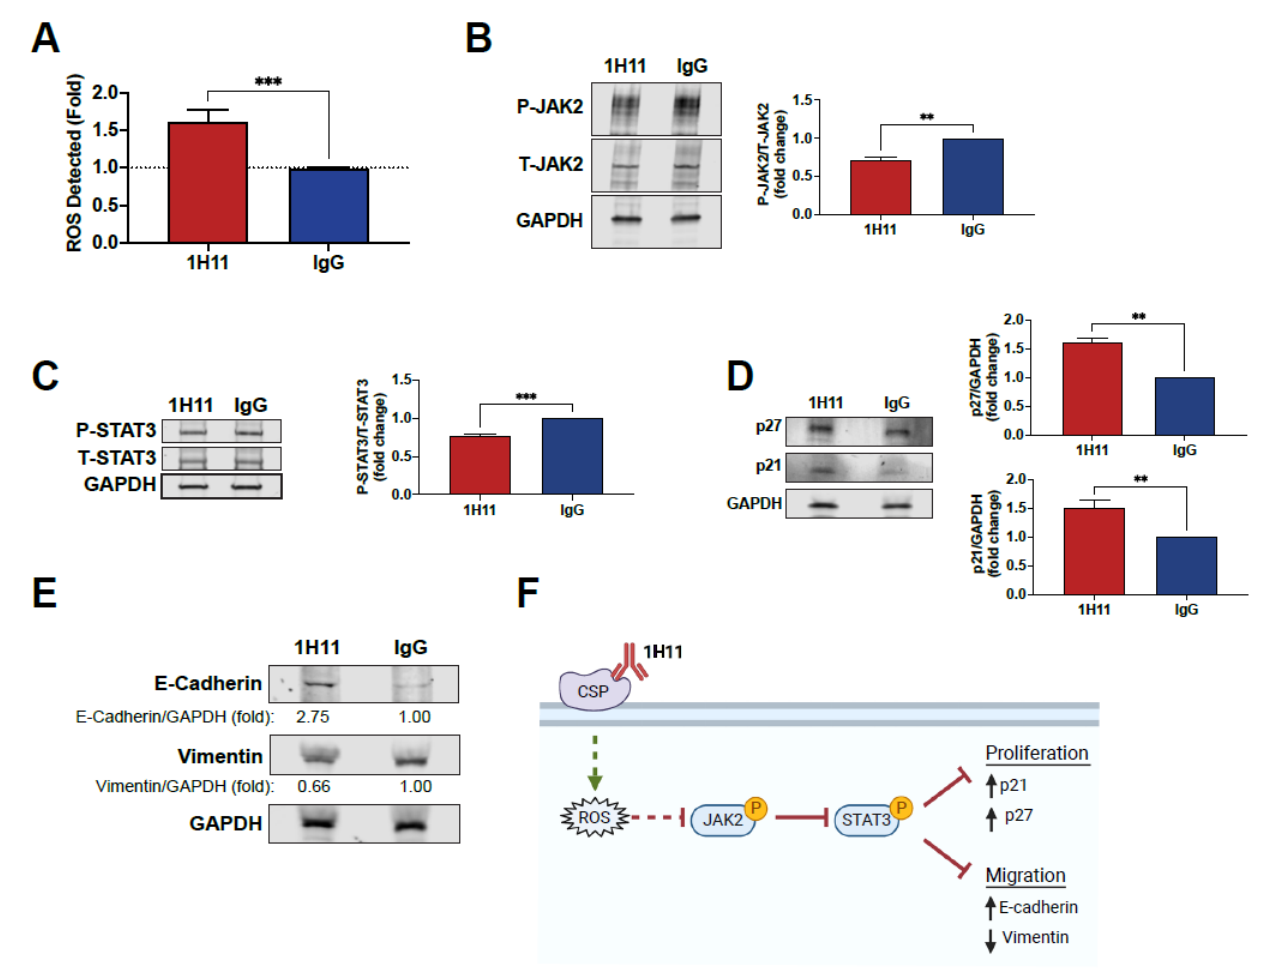
Figure 5. 1H11 induces ROS production and modulates the expression of critical proliferative and migratory effector proteins. ( A ) After 72 h of treatment, ROS levels were evaluated by DCFDA staining. 1H11 caused an increase in ROS levels. ( B , C ) Serum-starved cells were treated for 10 min, and lysates were accessed by Western blotting. 1H11 treated cells showed decreased phosphorylation of ( B ) JAK2 and ( C ) STAT3. ( D , E ) Cells were incubated with 1H11 or IgG for 72 h prior to harvest and evaluation by Western blotting. ( D ) 1H11 treatment resulted in an increased expression of two G1-checkpoint CDK inhibitors, p27 and p21. ( E ) An increase in E-cadherin and a decrease in vimentin protein expression were also observed. For Western blotting, GAPDH was used as a loading control. All experiments were performed by treating OVCAR8 cells with 125 nM 1H11 or IgG. All data plotted as mean ± SEM. *** p < 0.001, ** p < 0.01 vs. IgG. ( F ) Proposed molecular mechanism of 1H11.